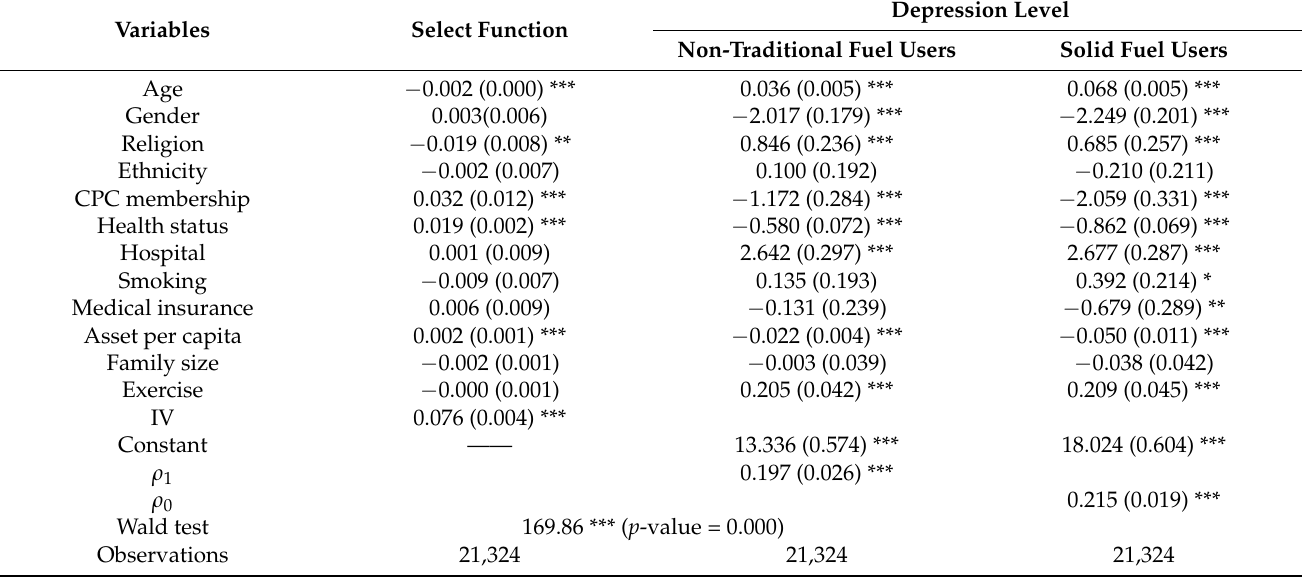
Table 3. The coefficients and standard errors of ESR model for the effect of non-traditional fuel choices on depression